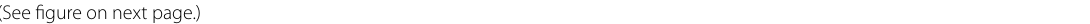
figure on next Fig. 4 Ionosphere vertical structure at 5 ionosonde locations within the grid, during the 2015 St. Patrick’s Day geomagnetic storm. Top, middle and bottom panels represent IRI-2016, reconstructed, and ionosonde observations, receptively. Stations in each panel are arranged in ascending geomagnetic latitude. Tick labels on top and bottom of each panel represent day of the year (DOY) and time in UT (~ LT-9 h), respectively. Scaled on the right of each image is Dst index, represented by the solid black line. Vertical dashed lines indicate the main events of the storm. In the IRI and reconstructed images, the purple solid-asterisk line shows the time variation of the hmF2 parameter at that ionosonde